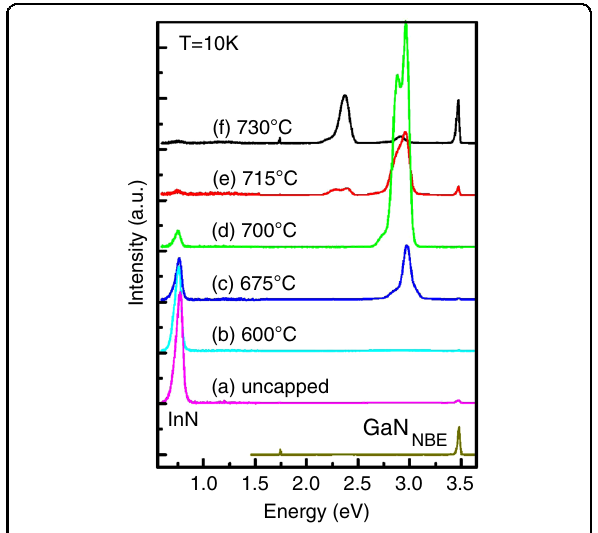
Fig. 7 Micro-PL at 10 K from InN QDs capped with GaN at varying GaN growth temperatures. Reprinted from Ku et al., Appl. Phys. Lett. 90 , 132116 (2007), with the permission of AIP Publishing 50